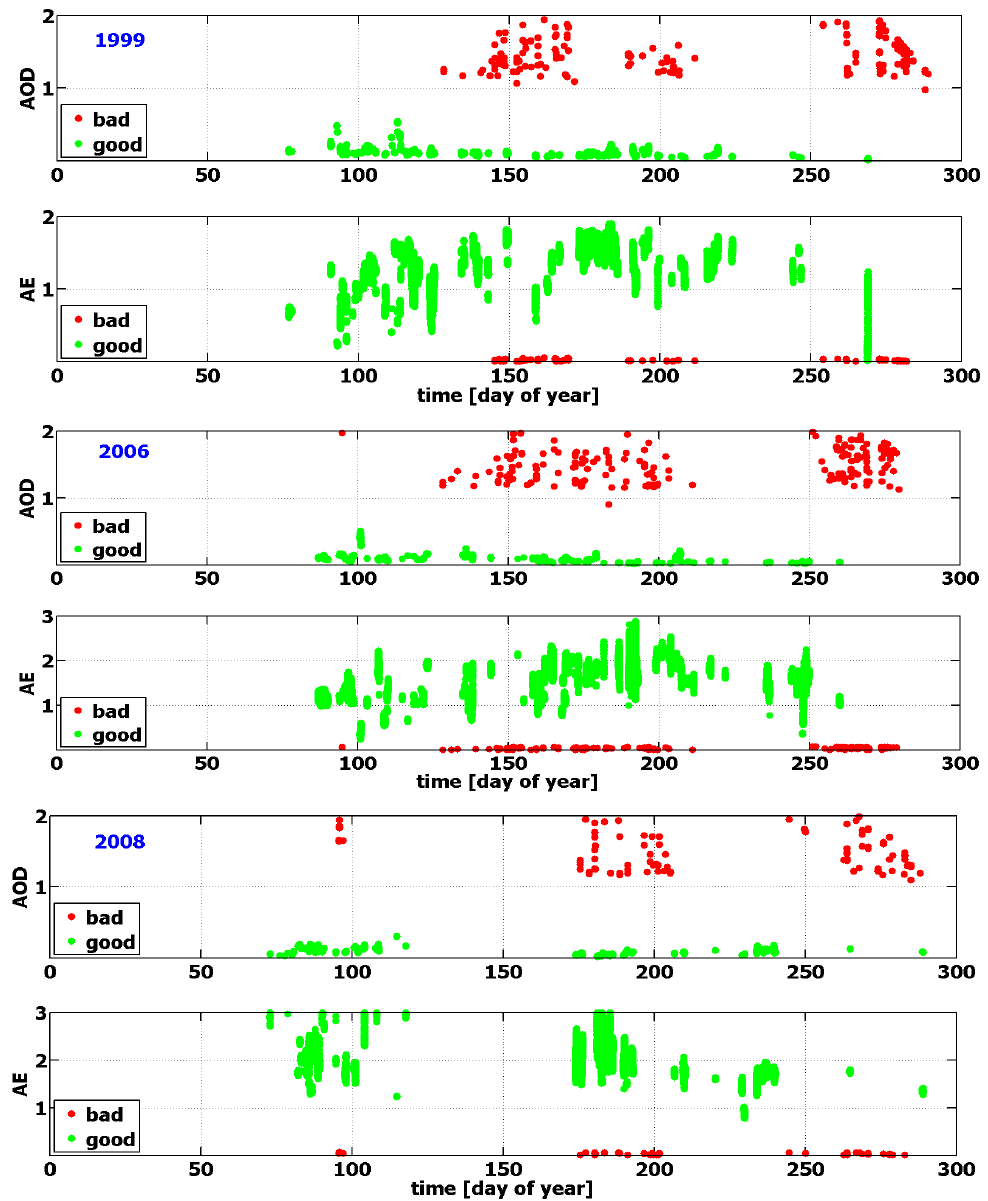
Figure 1. Example of cloud-screened time series of Multifilter Rotating Shadowband Radiometer (MFRSR)-derived aerosol optical depths (AOD) (at 0.5 μ m) and Angstrom exponent (AE) (0.415/0.870 μ m) as a function of day of year at the Atmospheric Radiation Measurement (ARM) North Slope of Alaska (NSA) site in Barrow (C1 MFRSR) for three years (1999, 2006 and 2008). Cloud screening was performed using standard (or original) algorithms. Red color indicates the likely cloud-contaminated points with large AODs and small AEs (“bad” points) undetected by the existing cloud-screening algorithms. Green color represents points with reasonable AODs and AEs (“good”